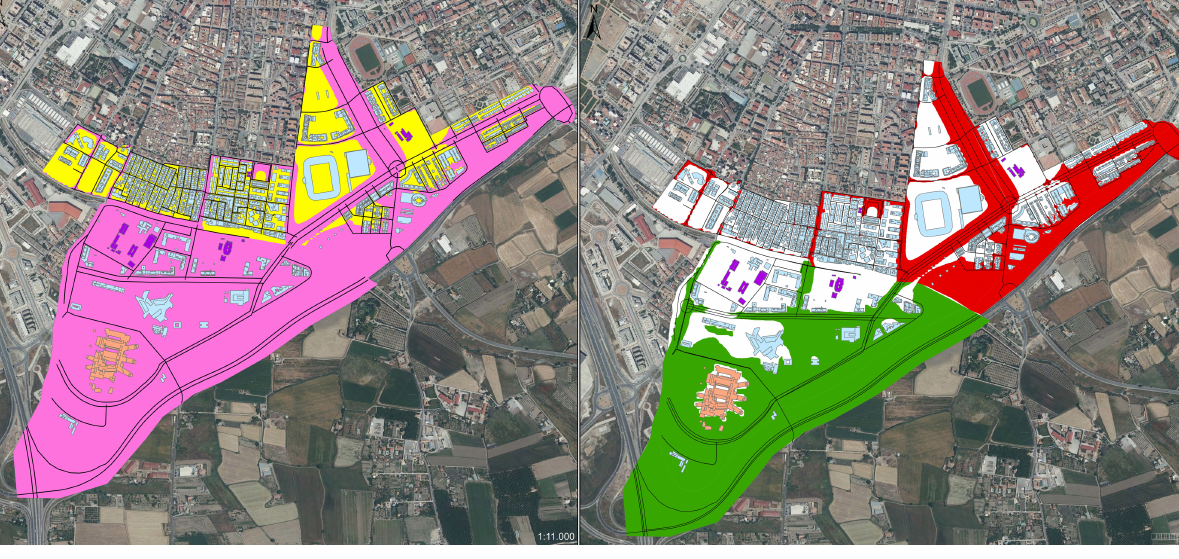
Figure 5: Detailed view of PTS study area (north up, as in Figure 2) in which ZPAE area is marked in pink (left), and MEUA is marked in red (right)